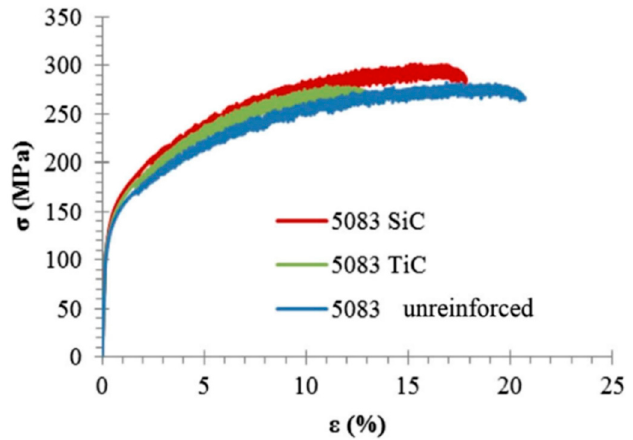
Figure 9. Stress–strain curve for joints without reinforcement and with SiC and TiC nanoparticle reinforcements.